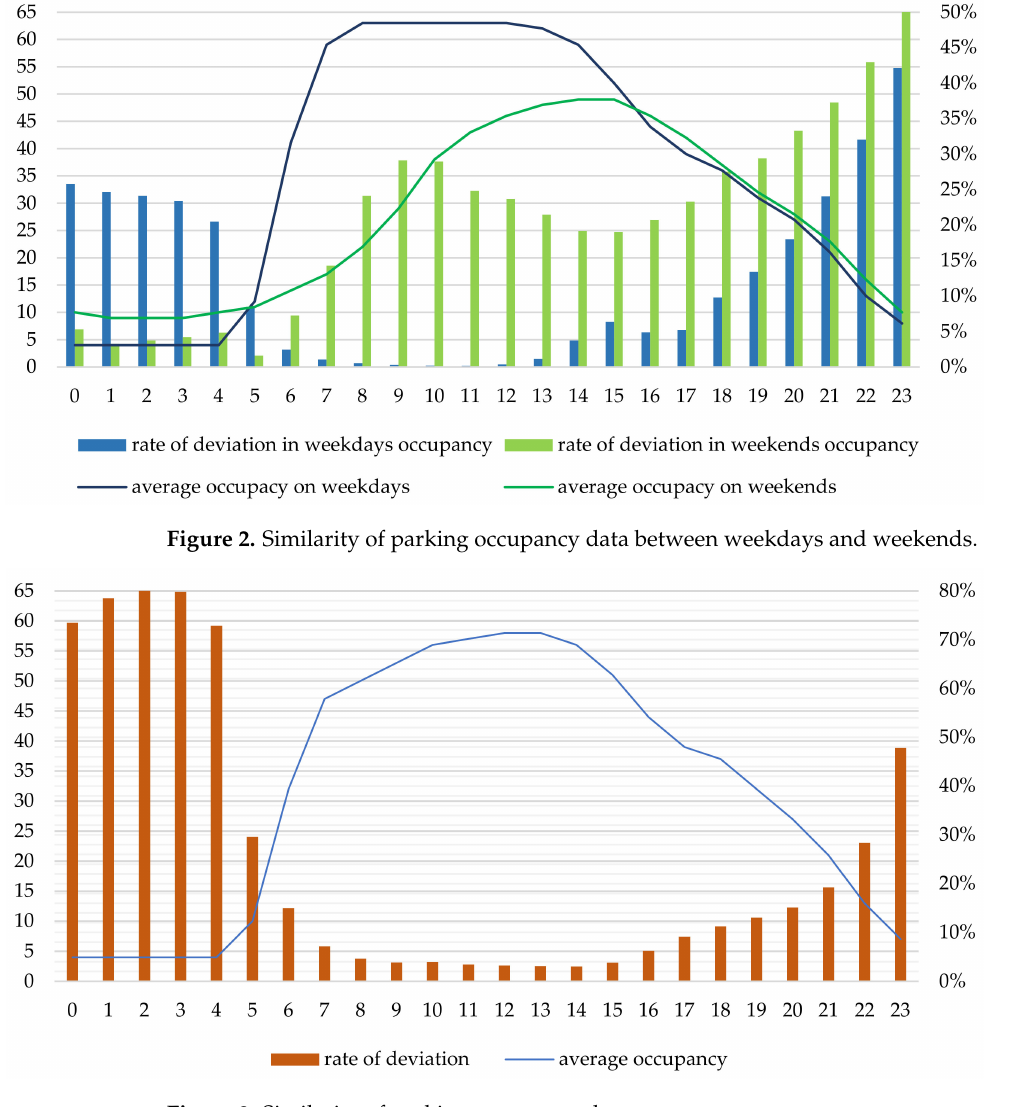
Figure 3. Similarity of parking occupancy data among